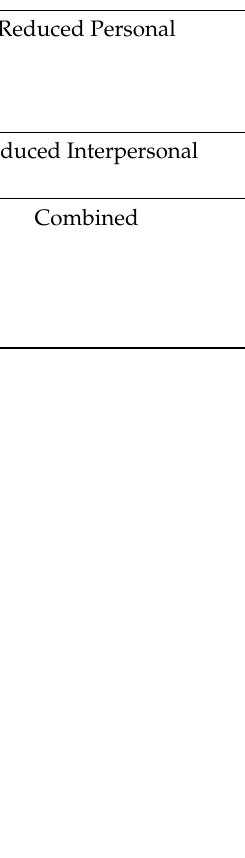
Table 4. Results of backward elimination linear regression evaluating variance in compassion satisfaction for Models 1 (individual variables), 2 (interpersonal variables), and 3